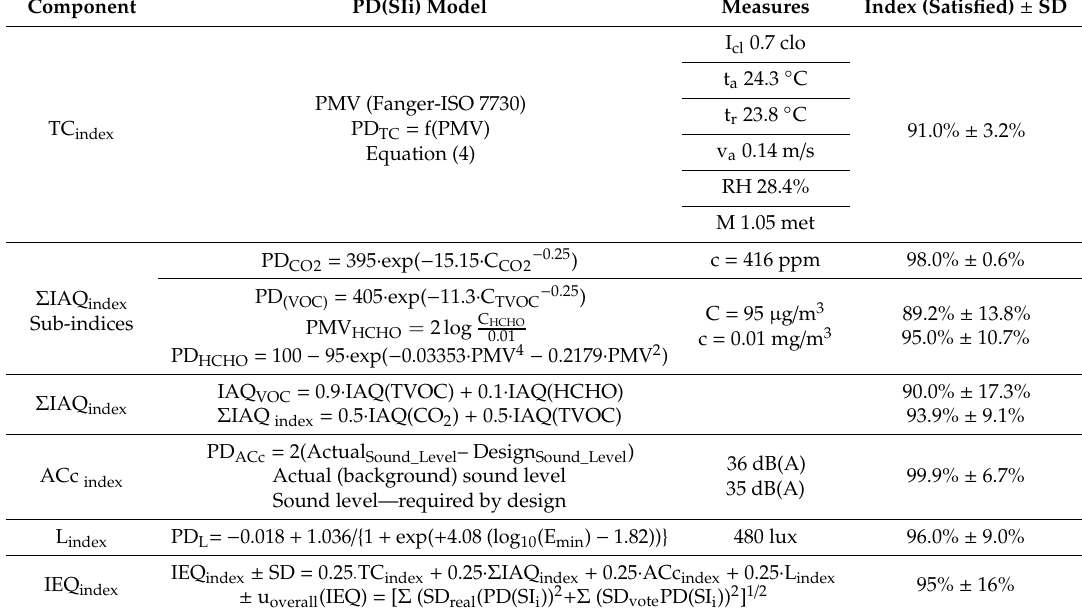
Table 9. The IEQ sub-component models, the indoor parameters (input values) and IEQ index results for building (P avg ) assuming the realistic uncertainty.